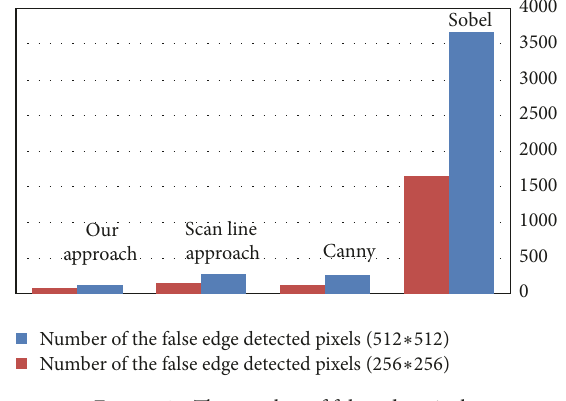
Figure 15: The number of false edge